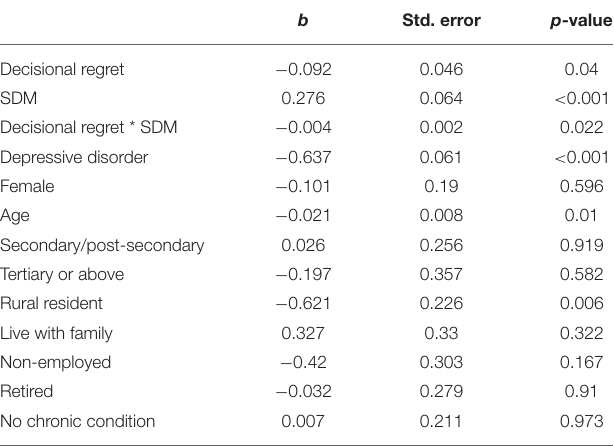
TABLE 4 | Results of regression